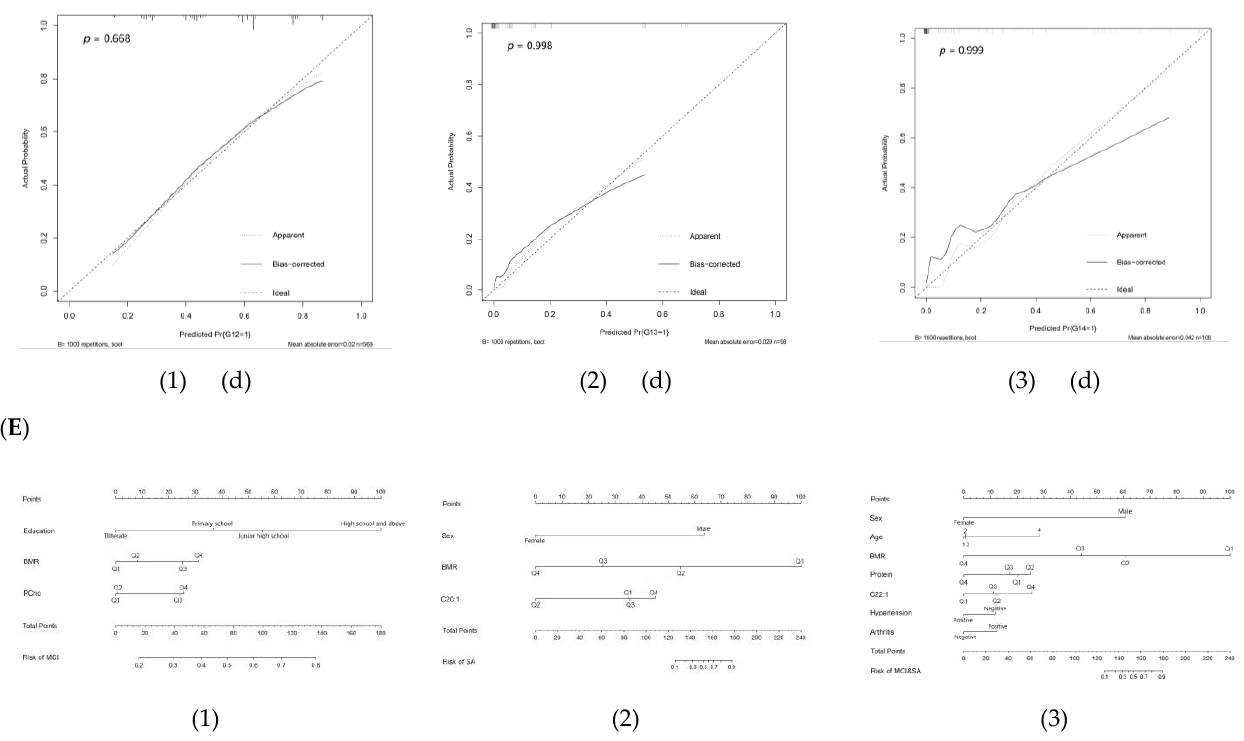
Figure 1. ( A ) Receiver operating characteristic curve analysis for predictive models. ( B ) Variables selection by least absolute shrinkage and selection operator (LASSO) logistic regression. The vertical dotted line points to the optimal lambda value and the number of optimal predictors. ( C ) Receiver operating characteristic curve validation of risk prediction model in the training and validation set. ( D ) Calibration curves of MCI, SA, and MCI and SA in the training and validation set. ( E ) Multivariate logistic regression analyses and nomogram for predicting the MCI, SA, and MCI and SA probability. (1) MCI – Ctrl group; (2) SA – Ctrl group; (3) MCI and SA – Ctrl group. (a) Selection of